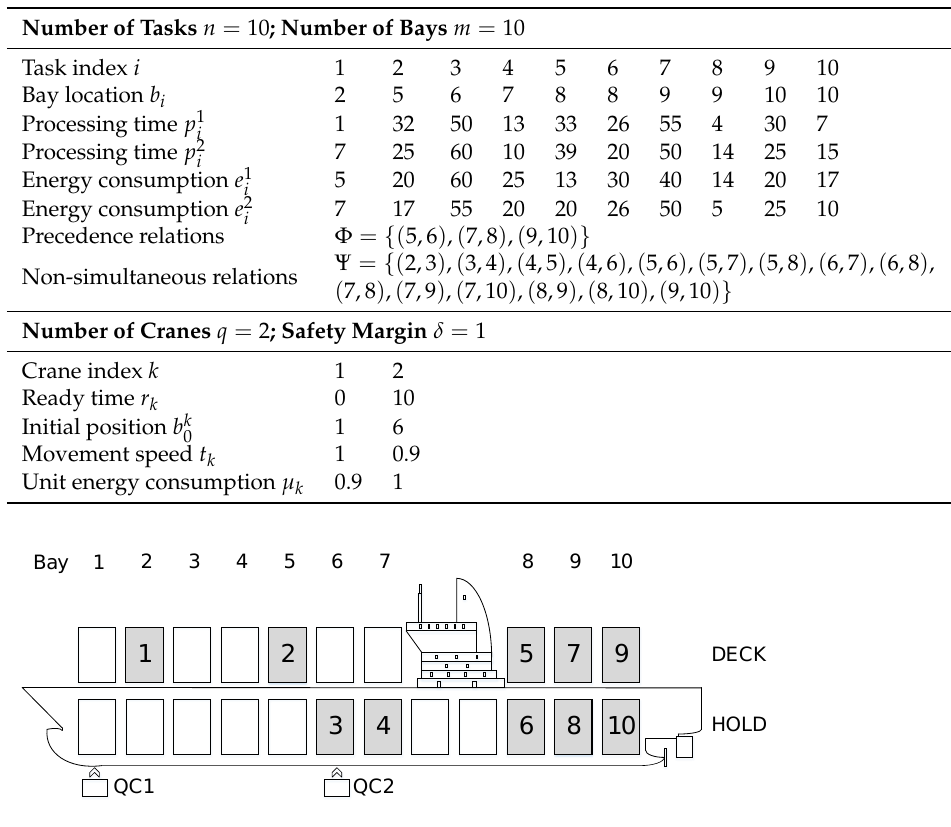
Table 3. Data for the case study.